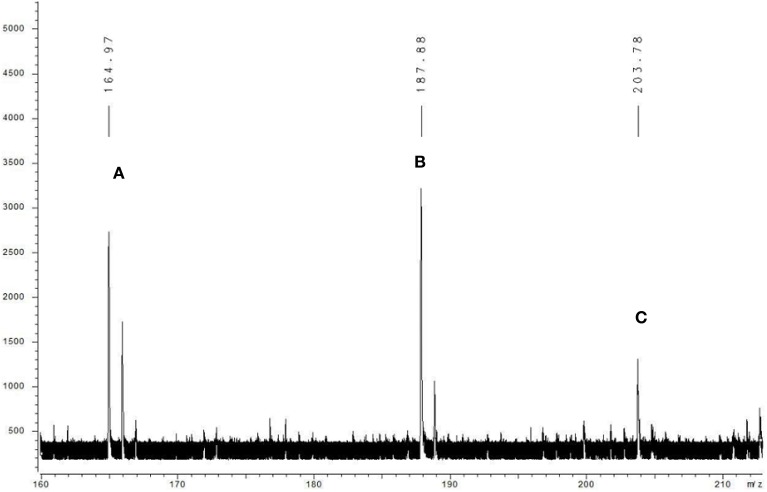
Mass spectrum of fraction C2 obtained with MALDI-TOF MS. The compound was dissolved in the carbon nanotube (CNT) matrix, and the data were recorded by positive ion mode. Letter A indicates the molecular ion peak, and B and C mark the positive ion peaks of [M+Na] + and [M+K]+, respectively.